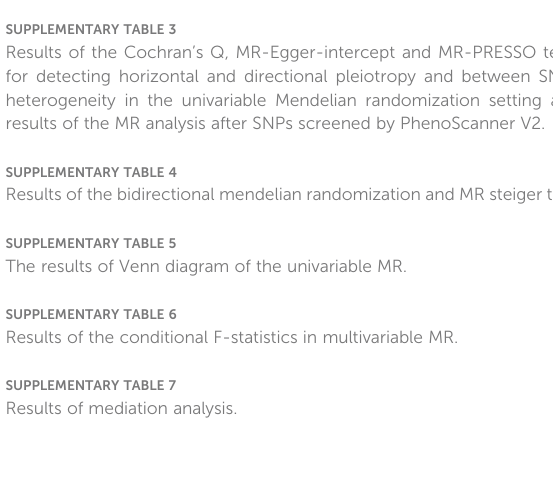
SUPPLEMENTARY TABLE 2 Extra information about the selected related SNPs.